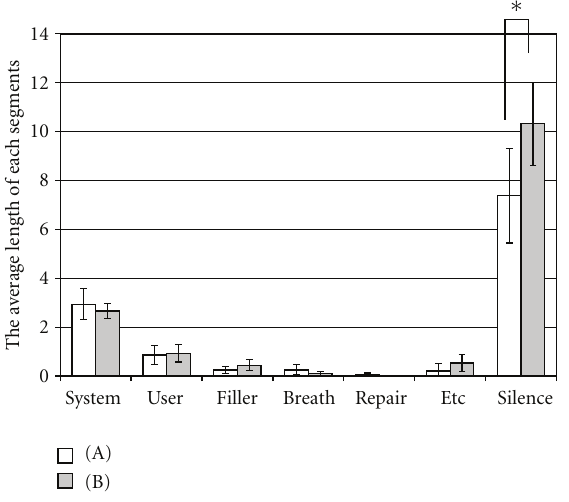
Figure 5: L 1 of each class ( ∗ P < 0 . 05).